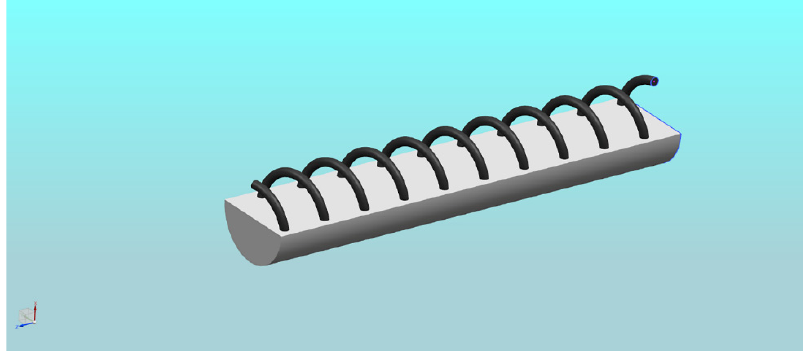
Figure 3. Half section of the 3D model of Al-based helical carbon fiber composite bar.